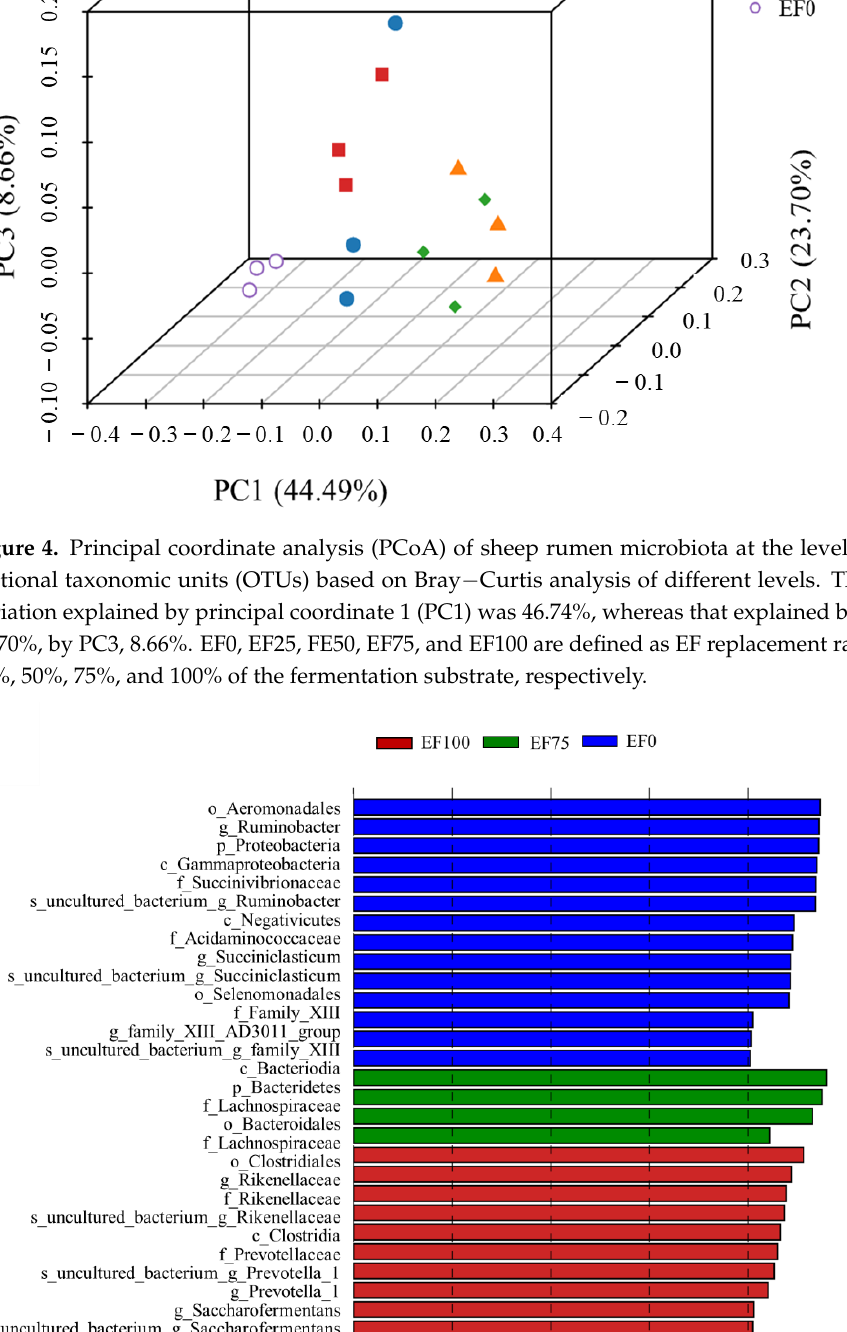
Figure 6. Cladogram of bacterial biomarkers from phylum (innermost ring) to genus (outermost ring) level, LDA score > 4. Differential bacterial taxa were marked with lowercase letters. The small circle of each different classification level represents the taxon of that level, and circle is directly proportional to the relative abundance. The principle of coloring is to use color the species. There was no significant difference in yellow, whereas other differential species are colored according to the group with the highest abundance. Different colors represent different groups, and nodes with different colors represent communities that play an important role in groups represented by colors.